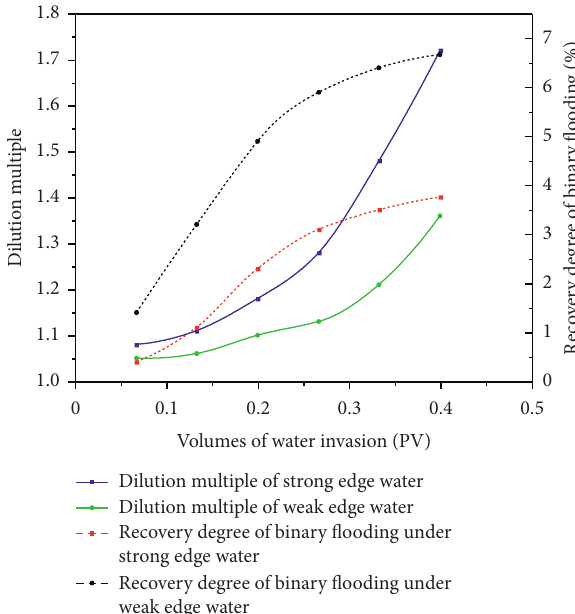
Figure 15: Dilution multiple under different volumes of water invasion and different edge water conditions.